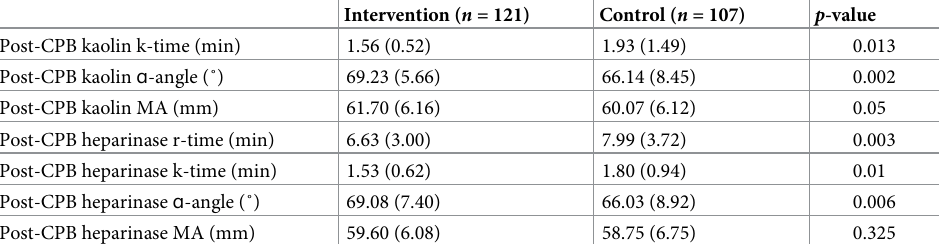
Table 4. Kaolin and heparinase post-CPB TEG results for participants allocated to the intervention (PRODOSE model) and control (fixed 1:1 ratio) groups. Intervention ( n = 121) Control ( n = 107)